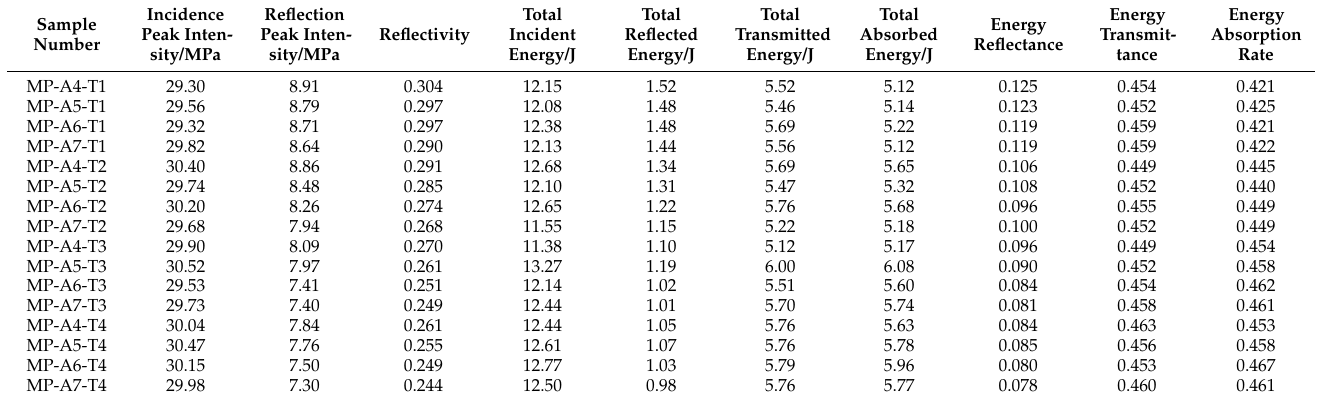
Table 3. Test results of wave-absorbing metal-plate materials.